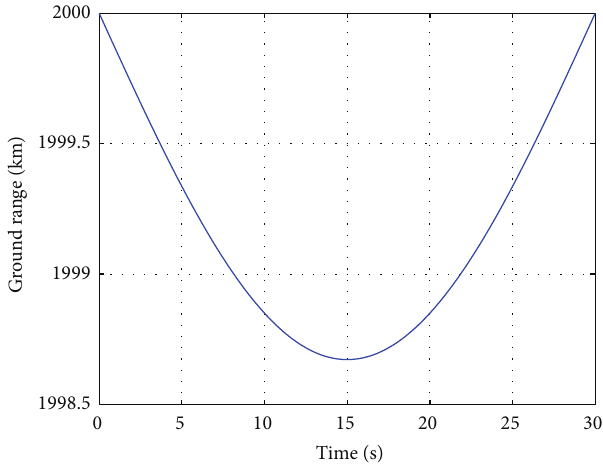
Figure 1: The target’s track in the range direction.